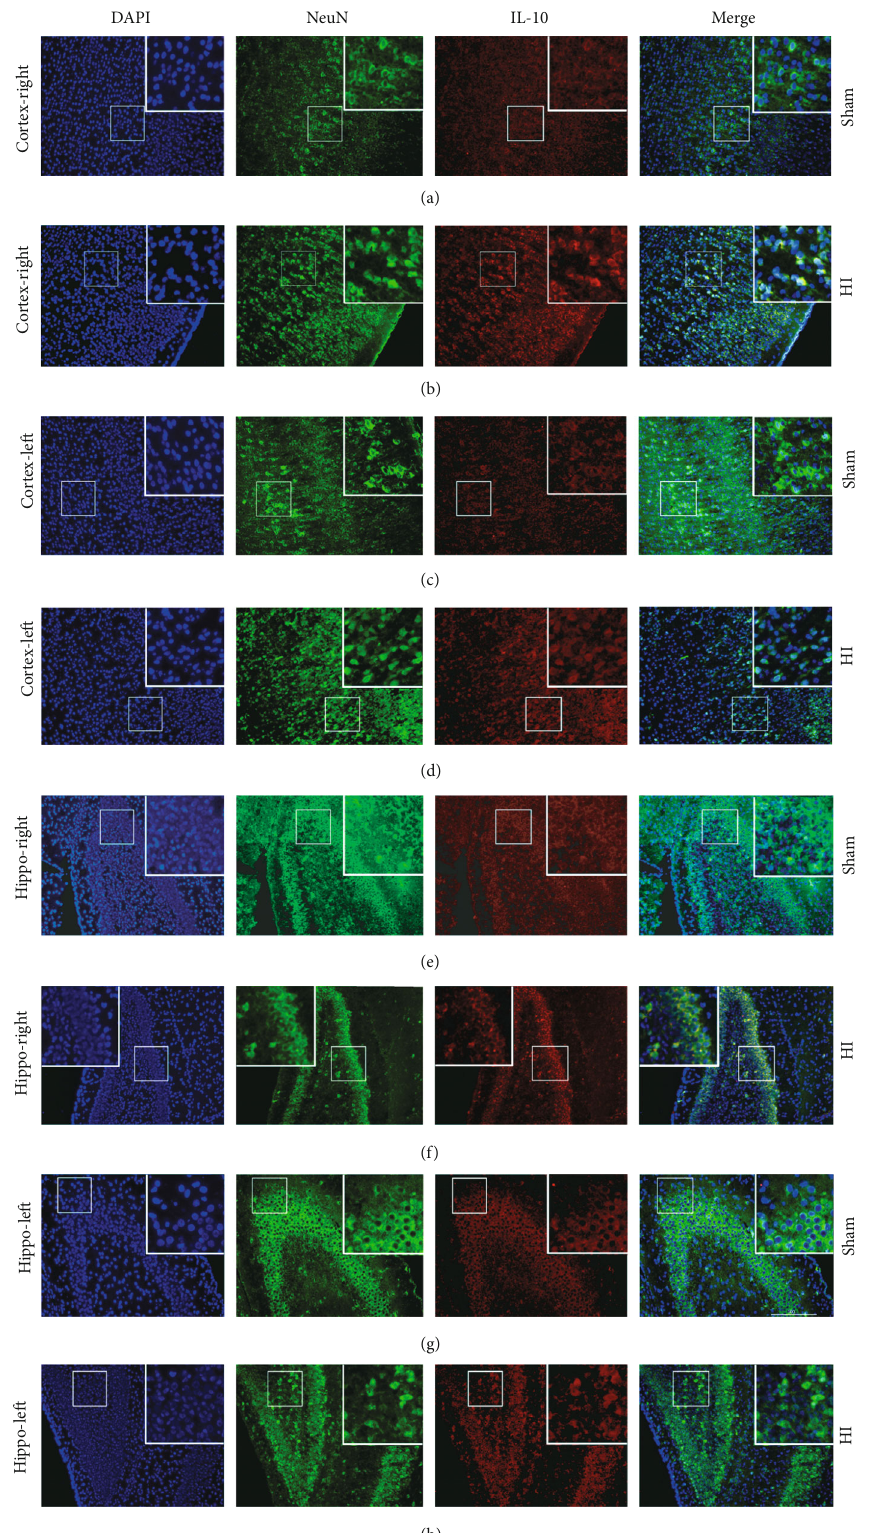
Figure 3: Immuno fl uorescence double staining of IL-10 and NeuN after HI. (a) – (h) The coexpression of IL-10 and NueN in the right and left cortex and hippocampus between sham and HI groups, respectively, by the immuno fl uorescence double staining. DAPI (blue) stained all nuclei, IL-10-positive cells glowed red, and the NeuN-positive neurons glowed green. Scale bar = 100 μ m . NueN: hexaribonucleotide binding protein-3; DAPI: 4 ′ ,6-diamidino-2-phenylindole; HI: hypoxia-ischemia; IL-10: interleukin 10; h: hour. N = 6